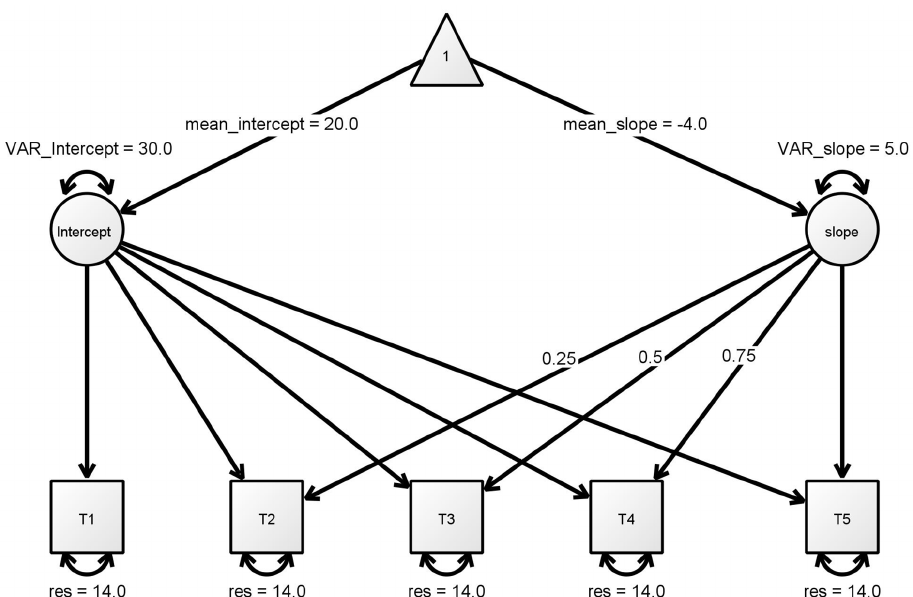
Latent Growth Curve Model Used for Analyzing the Data in the Larger